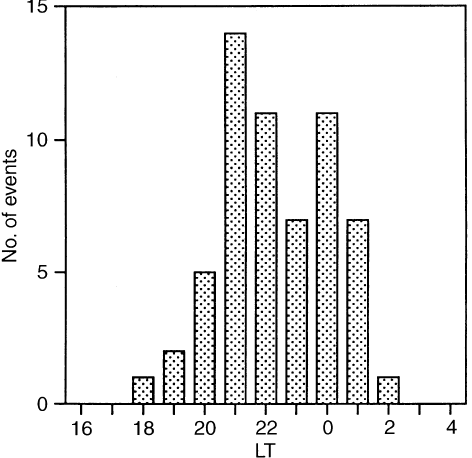
Fig 3. Local time distribution of the events in which both the field changes of the H and V components took place at GOES 5 or GOES 6 position at the Pi 2 onset. The satellite local time is used. The longitude of GOES 5 was the same as that of the ground station (LT = UT (cid:255) 5), while for GOES 6 the longitude was 2 h behind the ground station